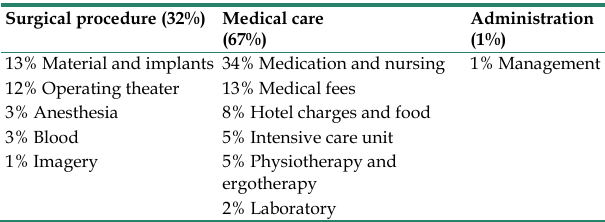
Table 4. Costs allocation for the 21